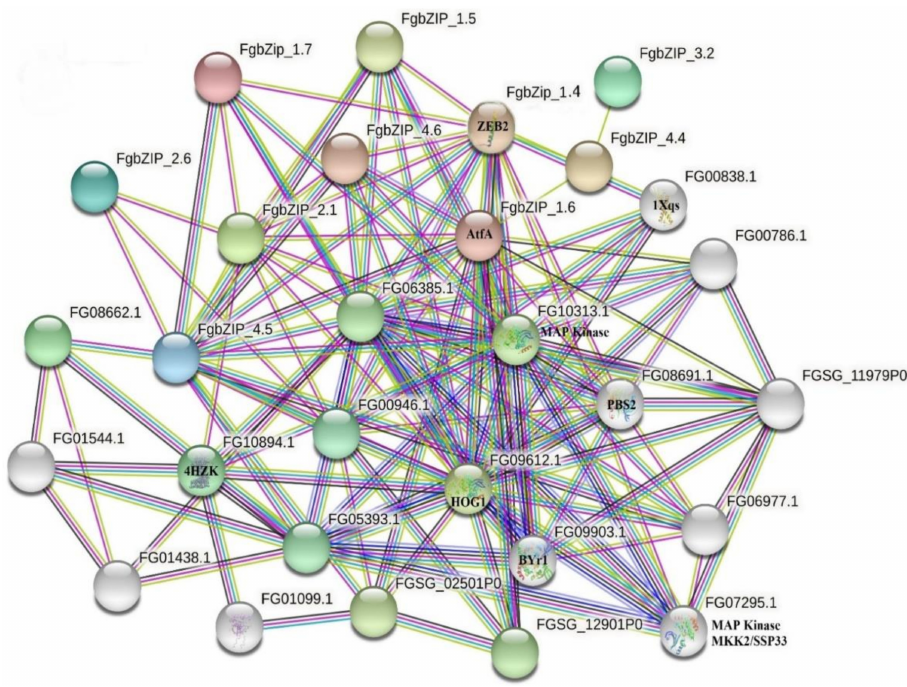
Figure 6. String network analysis of FgbZIP